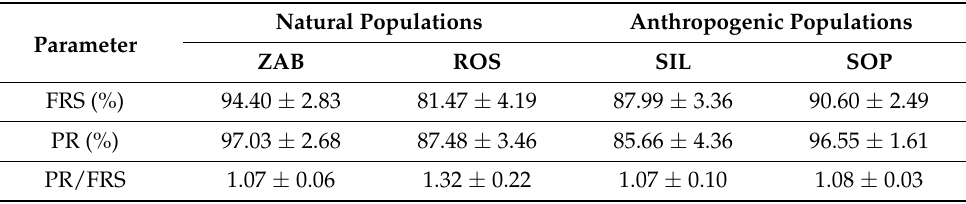
Table 3. Spatial and temporal variation of female reproductive success (FRS) and pollinaria removal (PR) in Epipactis palustris populations. Data ( n = 30) show the mean ± standard